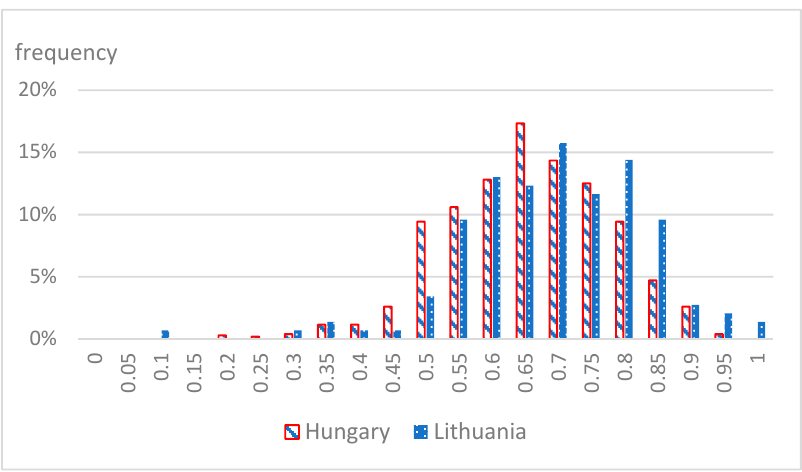
Figure 8. Histogram of the membership degrees assigned to engagement.